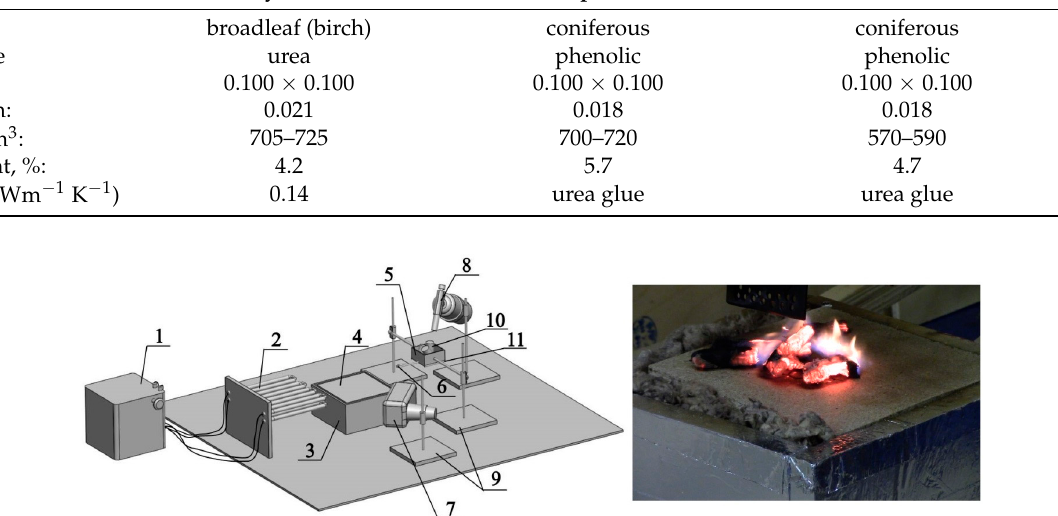
Figure 2. Schematic of the experimental setup: 1––laboratory autotransformer; 2––heating element; 3––pallet; 4––wood sample; 5––cuvette; 6––stopper; 7––heat blower; 8––burner; 9––tripods; 10––samples of firebrands; 11––bracket.